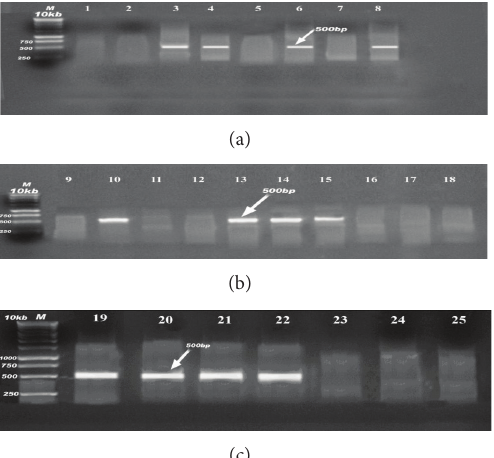
Figure 2: (a, b, c) Detection of papC gene in samples; positive samples produce band (500bp); lane M: 1Kb DNA Ladder; lanes 3, 4, 6, 8, 10, 13, 14, 15, 19, 20, 21, and 22 were the positive samples produced band (500